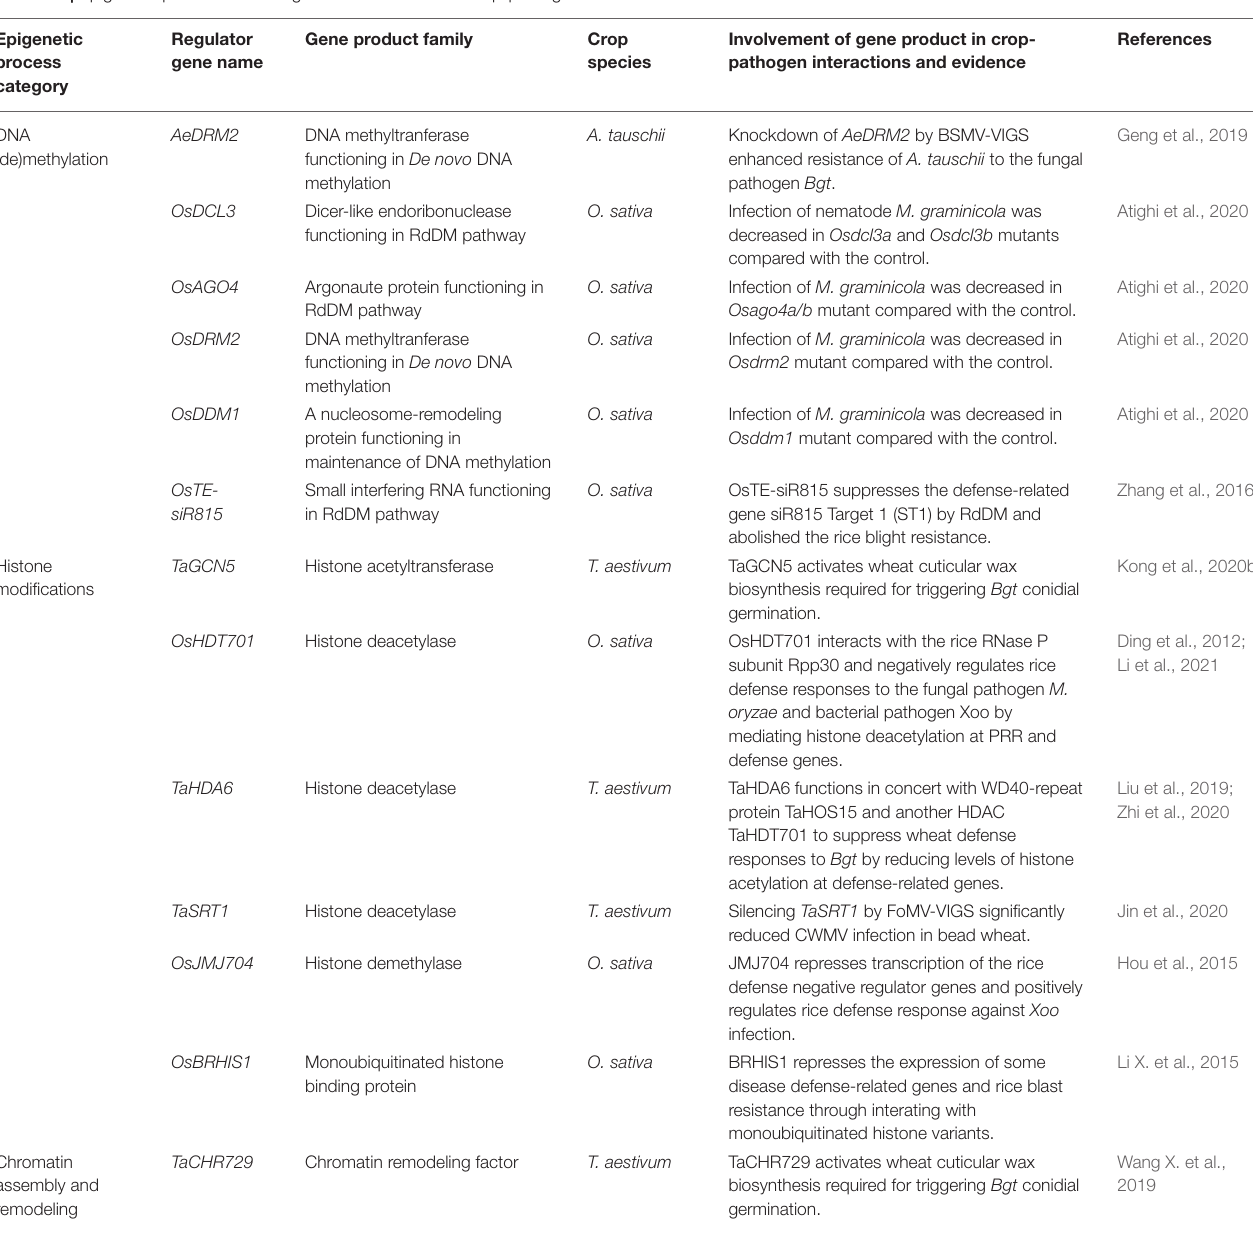
TABLE 1 | Epigenetic processes and regulators involved in the crop-pathogen